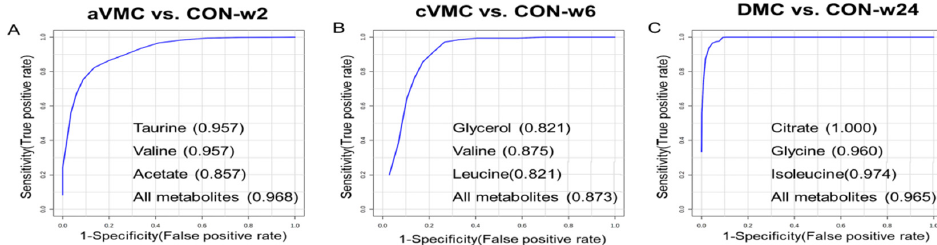
Figure 5. Multivariate ROC analysis of mouse sera for identifying potential biomarkers. ( A ) Taurine, valine and acetate identified from the ROC analysis of aVMC vs. CON-w2. ( B ) Glycerol, valine and leucine identified from cVMC vs. CON-w6. ( C ) Citrate, glycine and isoleucine identified from DMC vs.